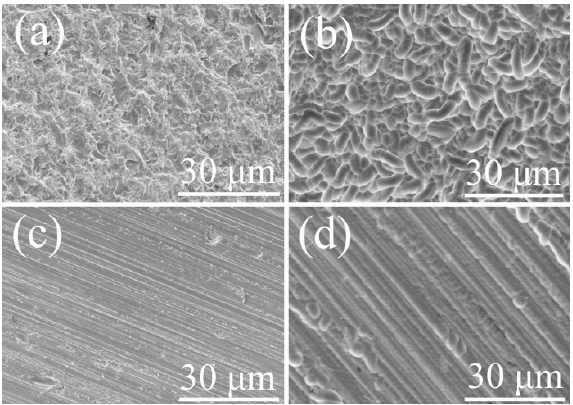
Figure 1. Scanning electron microscope (SEM) images of the structure before and after acid texture: ( a ) as-cut MWSS wafer; ( b ) MWSS wafer after acid texture; ( c ) as-cut DWS wafer; ( d ) DWS wafer after acid texture.